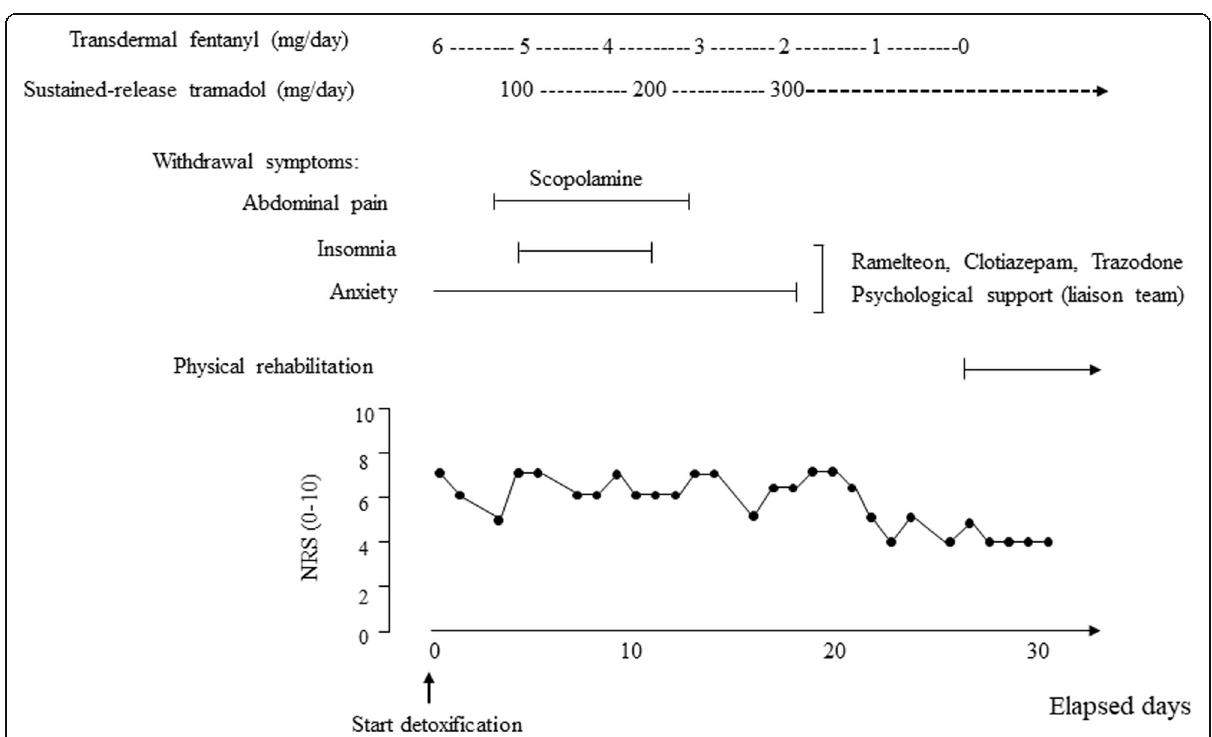
Fig. 2 Time course of fentanyl detoxification with sustained-release tramadol. Pain intensity was assessed using the NRS (Numerical Rating